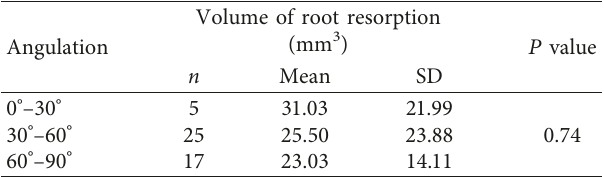
Table 5: Comparison of the MVR by distance between canine and midline.